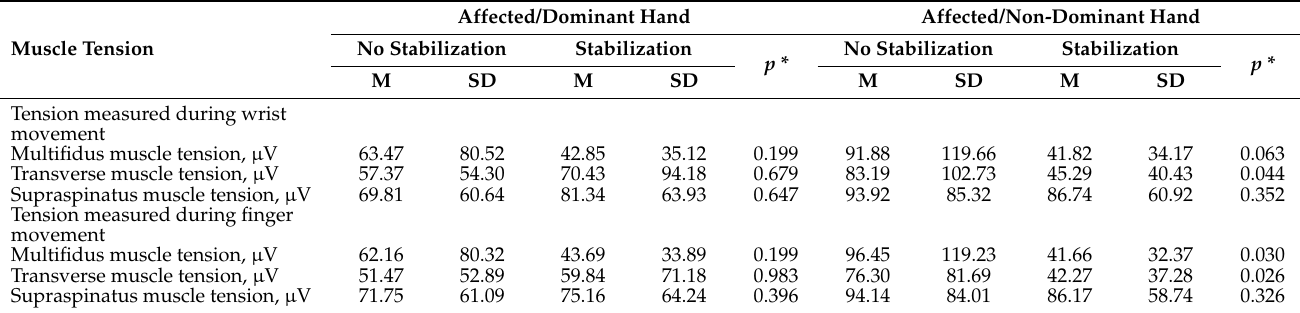
Table 6. Effect of hand dominance on muscle tension in stroke patients with and without stabilization of the trunk and upper